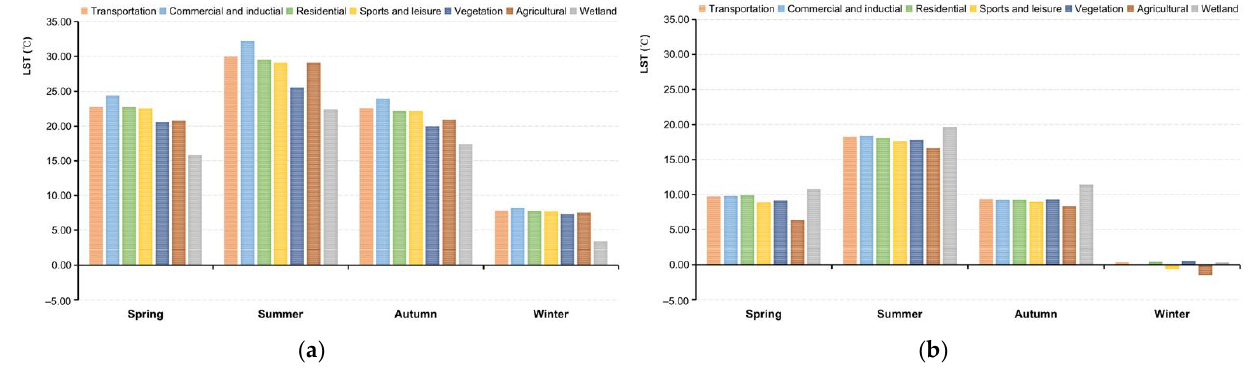
Figure 5. Seasonal variability of the average LSTs by different land cover type in ( a ) daytime and ( b ) nighttime.